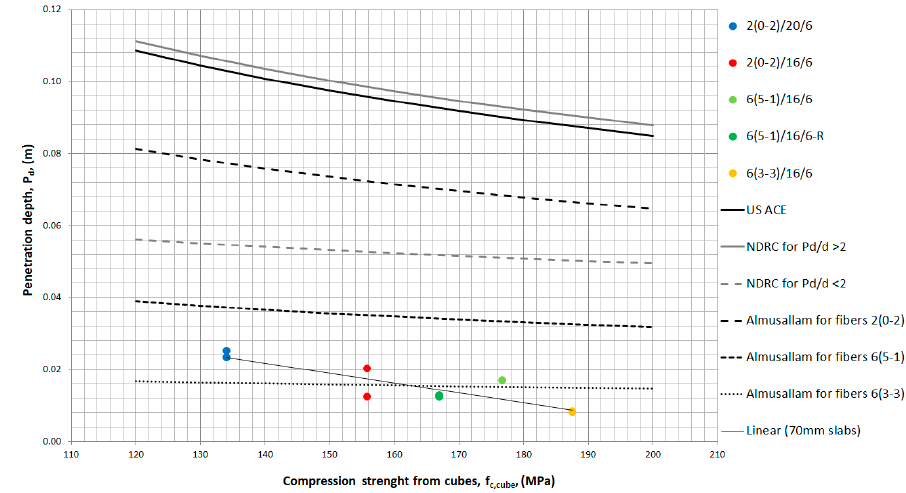
Figure 16. Comparison of experimental results of ultra-high performance fiber reinforced concrete (UHPFRC) mixtures (70 mm slabs) from impact and empirical formulas. Table 10. Penetration depth for mixtures 0/16/6 and HSC from empirical equations.